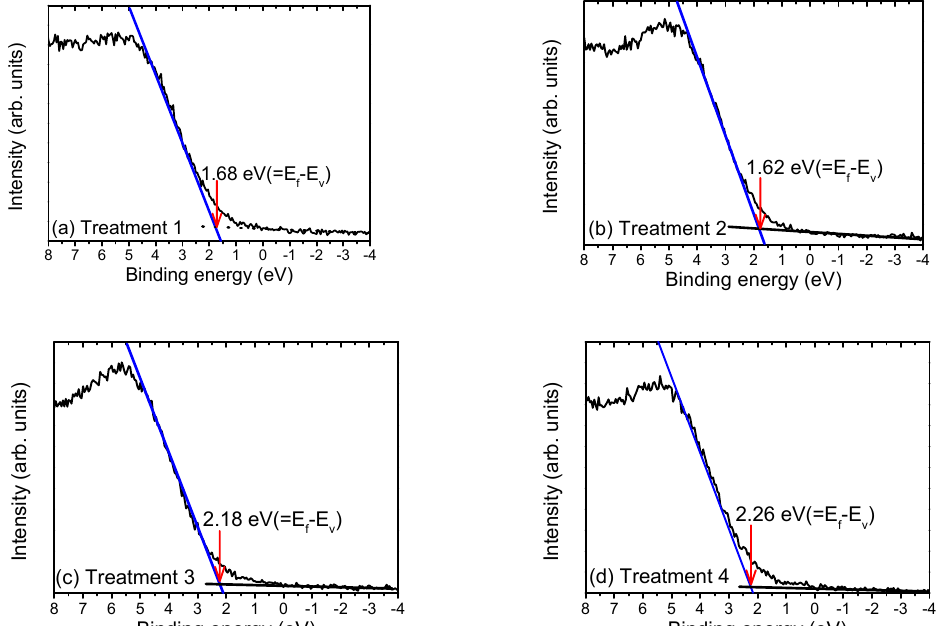
Figure 5. XPS valence band spectra of GaN after treatments with ( a ) treatment 1, ( b ) treatment 2, ( c ) c ) treatment 3, and ( d ) treatment treatment 3, and ( d ) treatment 4. (